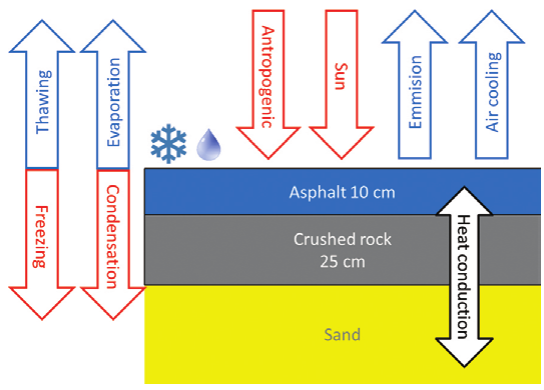
Fig. 1. Energy fluxes influencing the pavement temperature